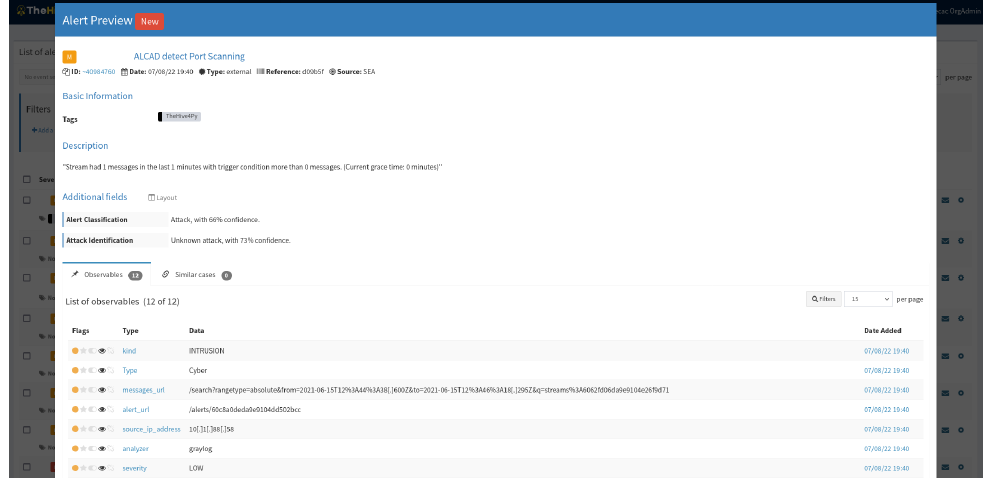
Figure 25. SMS-I Incident Response results for Network Scan example (TheHive view).